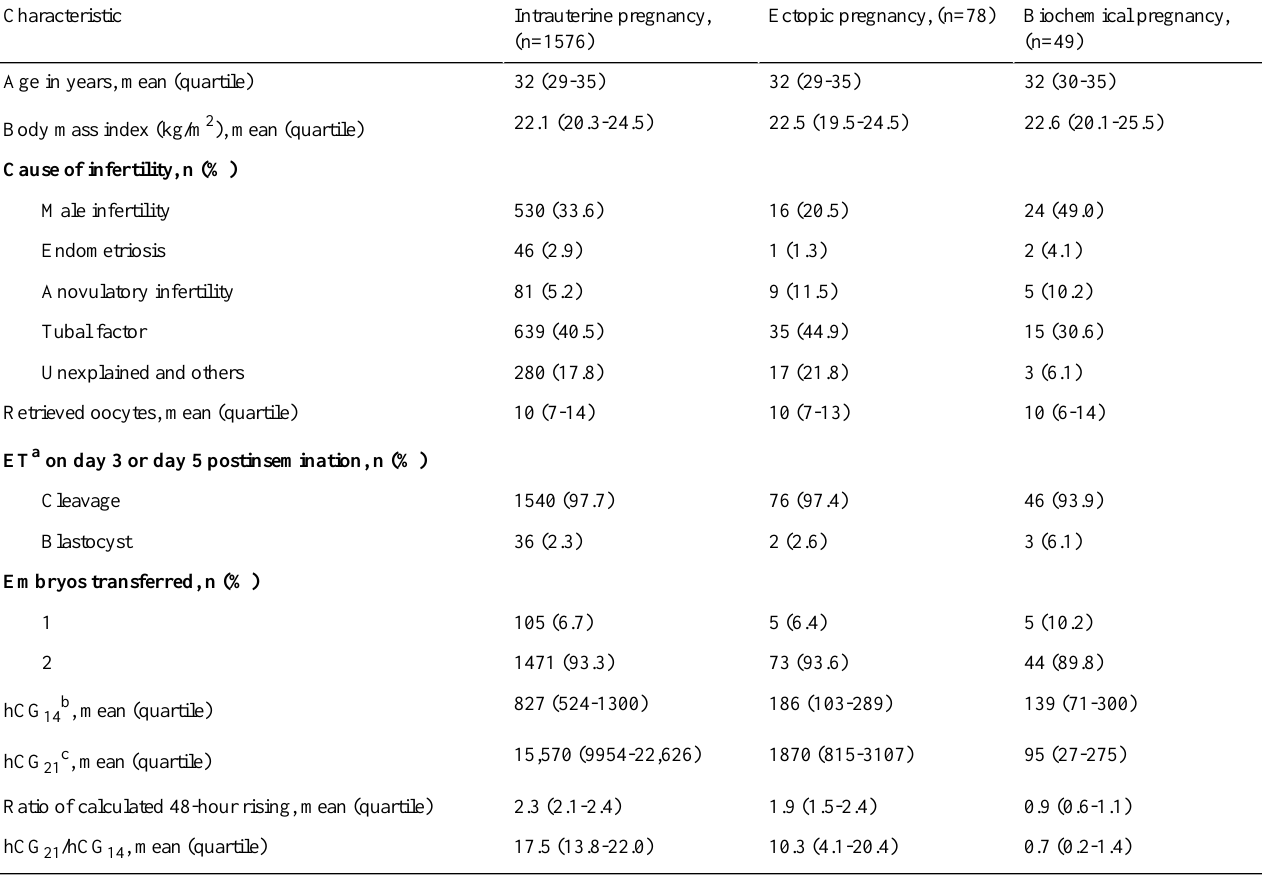
Table 1. Basic and clinical characteristics in related to different pregnancy